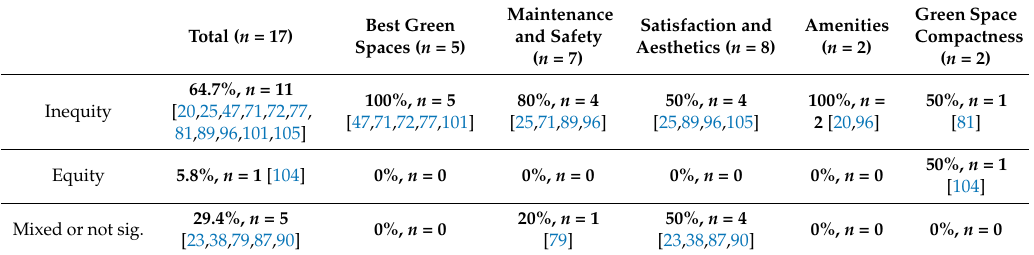
Green Space Maintenance Satisfaction and Amenities Best Green Compactness and Safety Aesthetics ( n = 8) ( n = 2) Spaces ( n = 5) ( n = 2) ( n = 7) 100%, n = 5 80%, n = 4 50%, n = 4 100%, n = 50%, n = 1 2 [20,96] [47,71,72,77,101] [25,71,89,96] [25,89,96,105] [81]